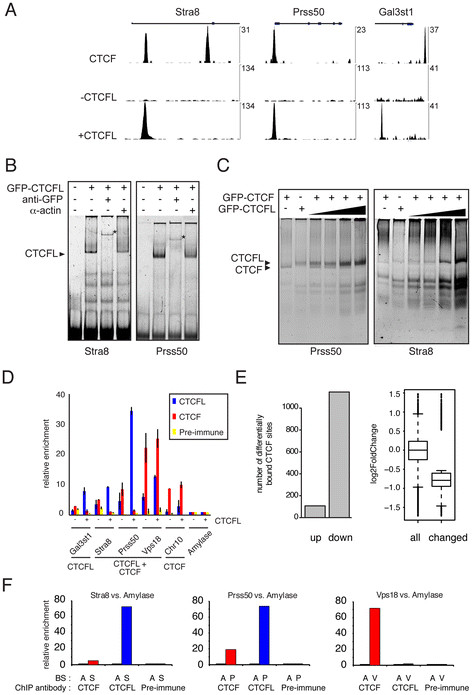
Characterization of CTCF and CTCFL binding. A Examples of CTCF- and CTCFL-binding site location. The genomic location of CTCF (upper part) and CTCFL (middle and bottom parts) binding sites in the absence (−CTCFL, middle) or presence (+CTCFL, bottom) of CTCFL, within the Stra8, Prss50 and Gal3st1 genes. The vertical axes show the number of unique sequence reads. B CTCFL binds to Stra8 and Prss50. Band shift analyses of GFP-CTCFL on Stra8 and Prss50 fragments. GFP-CTCFL binding can be super shifted (marked with asterisks) with anti-GFP, but not with an Actin antibody. Band shifts were performed under excess probe conditions. C In vitro effect of CTCFL on CTCF binding. Band shift analyses with GFP-CTCF and/or GFP-CTCFL on Prss50- and Stra8-bindings sites. GFP-CTCFL is added in increasing amounts (1-, 2-, 5- and 10-fold compared to GFP-CTCF). To allow competition, the band shift was performed under probe-limiting concentrations. D Cellular effect of CTCFL on CTCF binding. ChIP analyses with CTCFL (blue), CTCF (red) and pre-immune (yellow) antisera in ES cells that were either non-transfected (−) or transiently transfected CTCFL-V5-GFP (+). According to ChIP-sequencing data, Prss50, Stra8 and Vps18 bind both CTCF and CTCFL, whereas Gal3st1 only binds CTCFL, and Chr10 only binds CTCF. A CTCF- and CTCFL-negative site within the Amylase gene is used as reference and set to 1. Error bars represent standard deviations of biological replicates. E Competition between CTCF and CTCFL in ES cells. Genome-wide binding of CTCF was compared to that of CTCFL by ChIP-Seq using non-transfected ES cells and ES cells transiently transfected with GFP-CTCFL. The left hand panel shows the effect of CTCFL binding on shared CTCFL/CTCF sites that showed >1.5 fold difference in CTCF binding. The effect is categorized into sites with increased (up) or decreased (down) CTCF binding. The right hand panel shows a more general effect of CTCFL binding on CTCF binding. Here, we examined the change in CTCF binding in all shared CTCF(L)-binding sites (all) compared to those shared sites that were significantly changed in CTCF binding (changed). The effect on CTCF binding is plotted as log2-fold difference. F In vivo CTCF(L) binding. ChIP was performed using anti-CTCF (red) or anti-CTCFL (blue) antibodies, or pre-immune serum, on the indicated sites (A: Amylase, S: Stra8, P: Prss50, V: Vps18) in nuclei from dissociated seminiferous tubules, partly purified by elutriation. Relative enrichment is shown compared to Amylase.